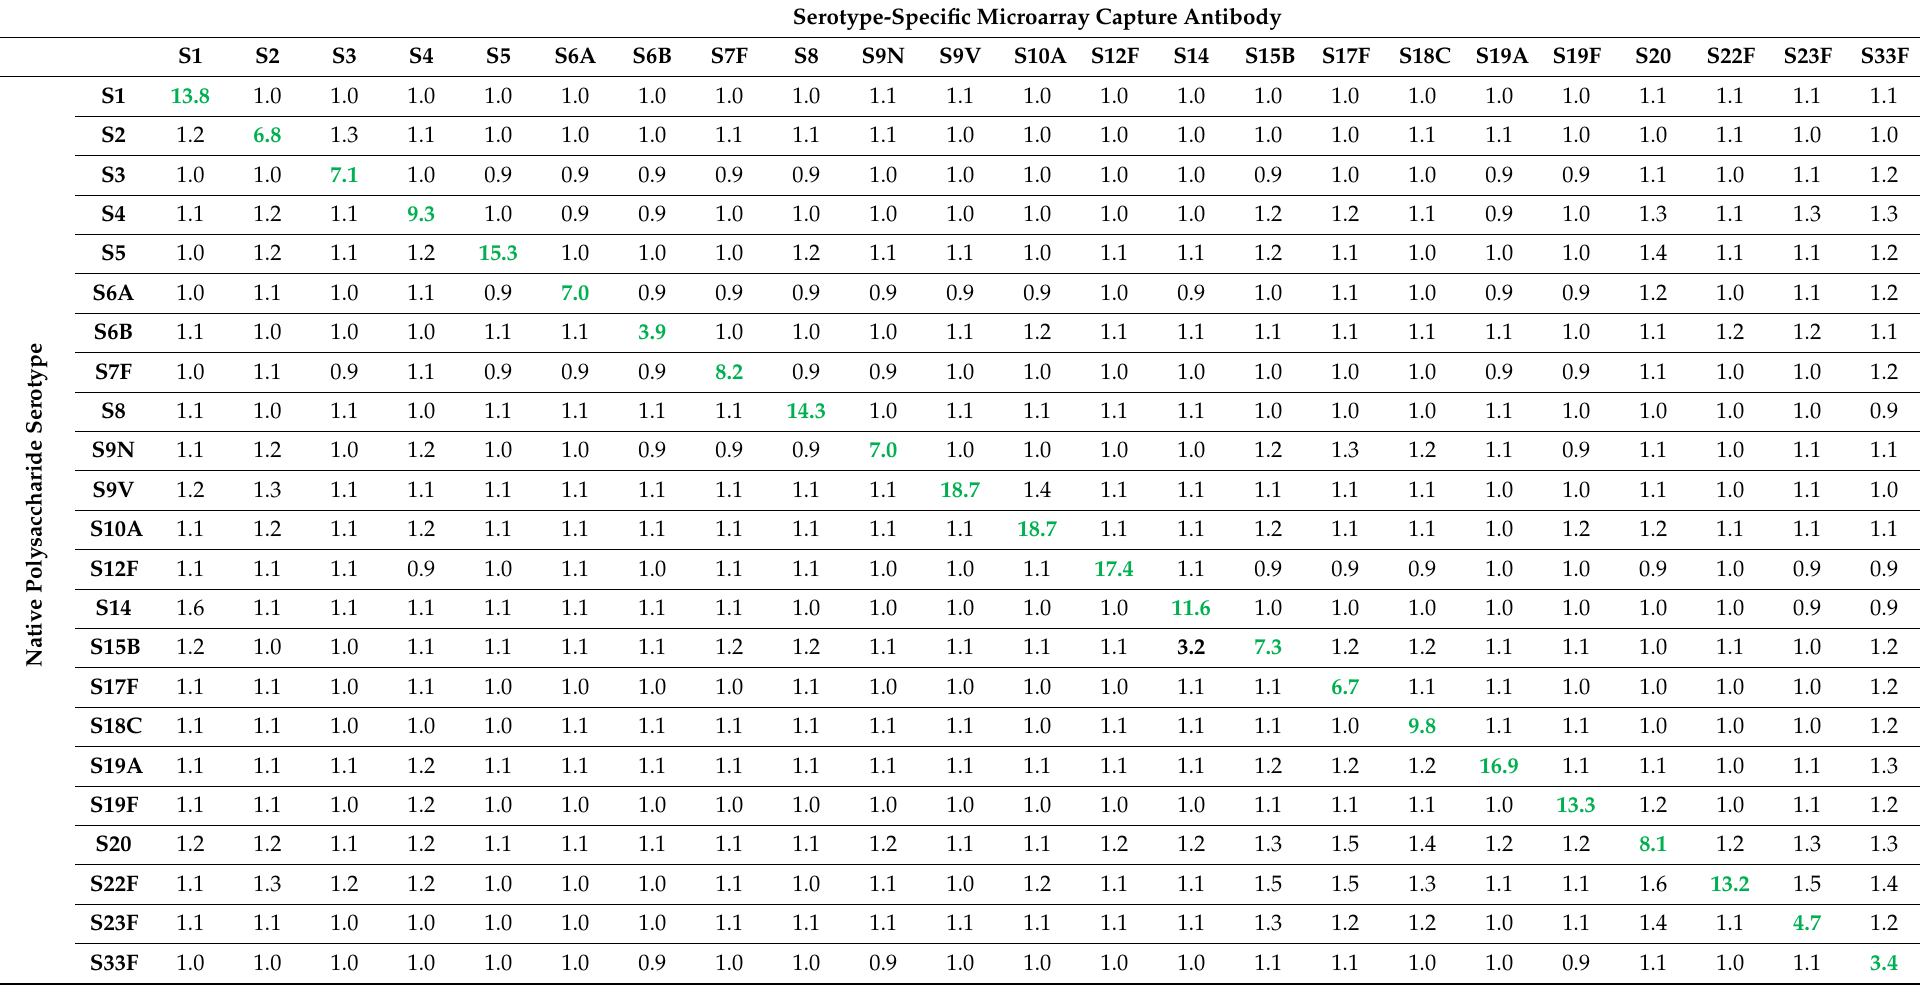
Table 1. Native PS reactivity. Signal-to-blank ratios (S/Bl) on the VaxArray 23-valent pneumococcal assay for Pfizer native PS materials (ATCC, deposited by Pfizer) at 2 µ g/mL; columns represent each serotype-specific capture antibody, and rows represent each serotype of native PS tested. Text in bold green shows S/Bl ≥ 3 generated for the matched PS and capture antibody. Text in bold black shows S/Bl ≥ 3 generated on off-target capture antibody indicating